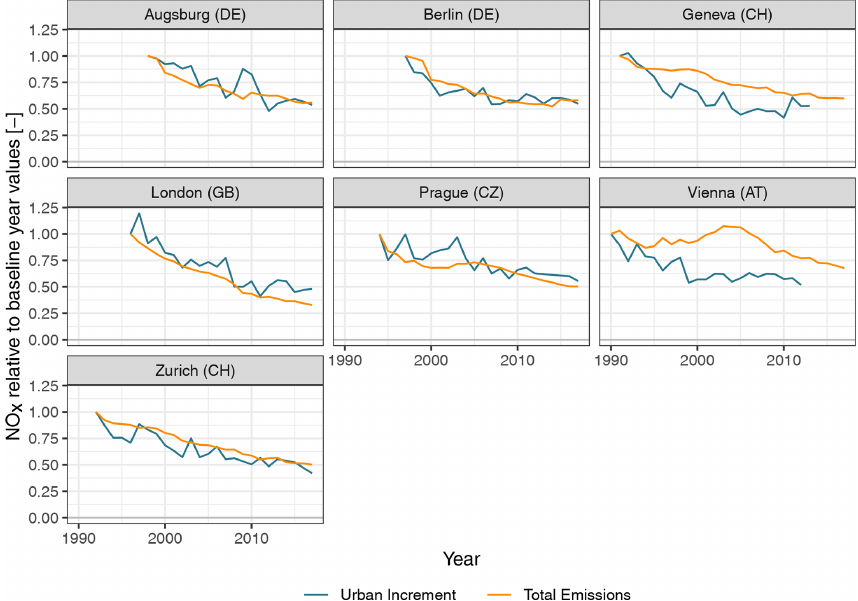
Figure 2. Urban increments (UIs) and total emissions of NO x for seven European cities, relative to their values from a baseline year which was defined individually for each city dependent on the data availability. The UIs are derived from rural and urban background monitoring stations; emissions are averaged for the urban areas based on the EMEP emissions